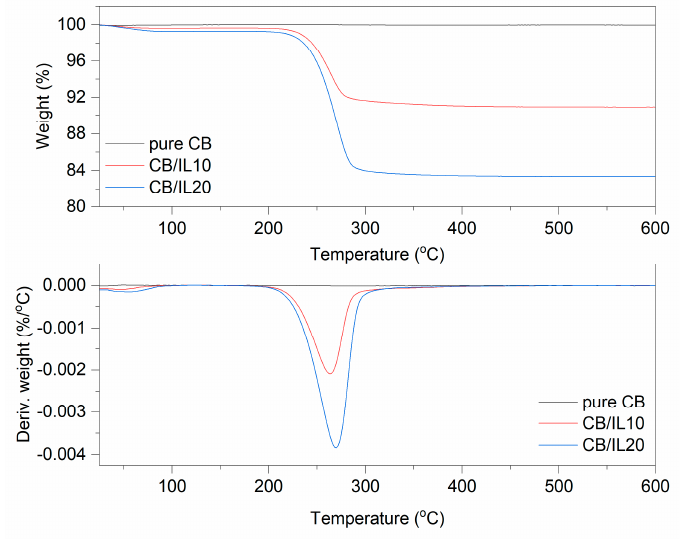
Figure 4. TG and DTG curves for pure and DmiBr-modified CB.